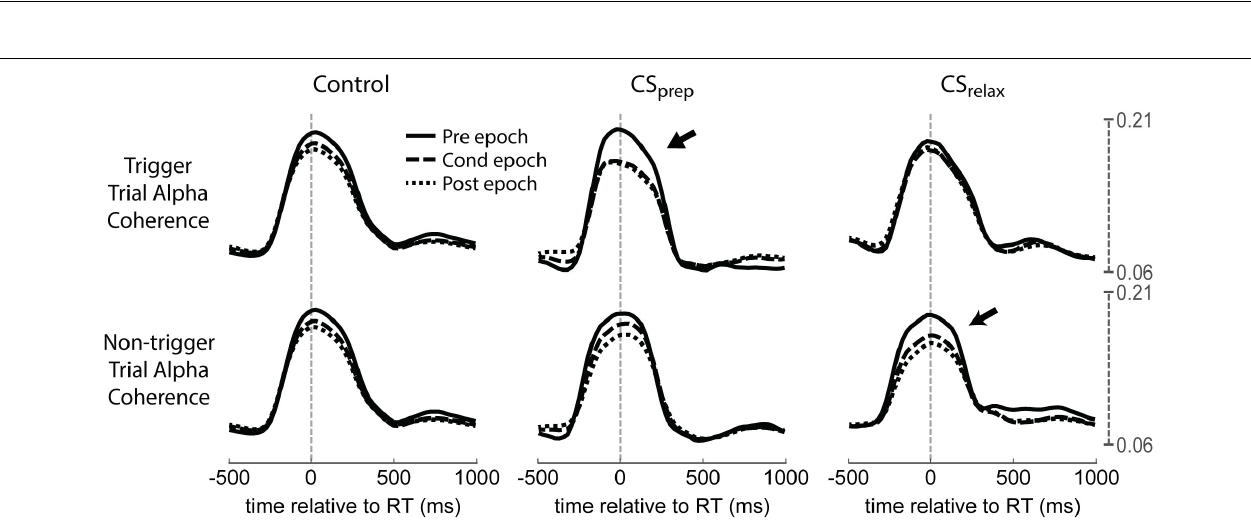
FIGURE 11 | Coherence in Contralateral CS experiments. Coherence during each experimental epoch for CS prep and CS relax . Contralateral and ipsilateral refers to limb movement relative to the stimulated hemisphere. Notice the large decrease in contralateral alpha coherence during CS prep and ipsilateral alpha during CS relax (arrows); both RTs decreased during stimulation ( Figure 3 ). CS move did not produce any significant changes. See Supplementary Figure 5 for both alpha and beta coherence for all Contralateral CS conditions.